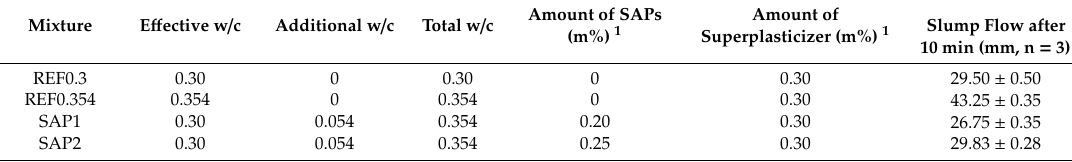
Table 1. Composition of the cement pastes, showing the e ff ective (–), the entrained (–) and the total water-to-cement ratio (–), with the amount of SAPs (m%), the amount of superplasticizer (m%) used and the slump flow of the mixtures measured 10 min after the first contact with water (mm). Amount of Amount of SAPs Mixture E ff ective w / c Additional w / c Total w / c Slump Flow after Superplasticizer (m%) 1 (m%) 1 10 min (mm, n = 3) REF0.3 0.30 0 0.30 0 0.30 29.50 ± 0.50 REF0.354 0.354 0 0.354 0.30 1 m% versus